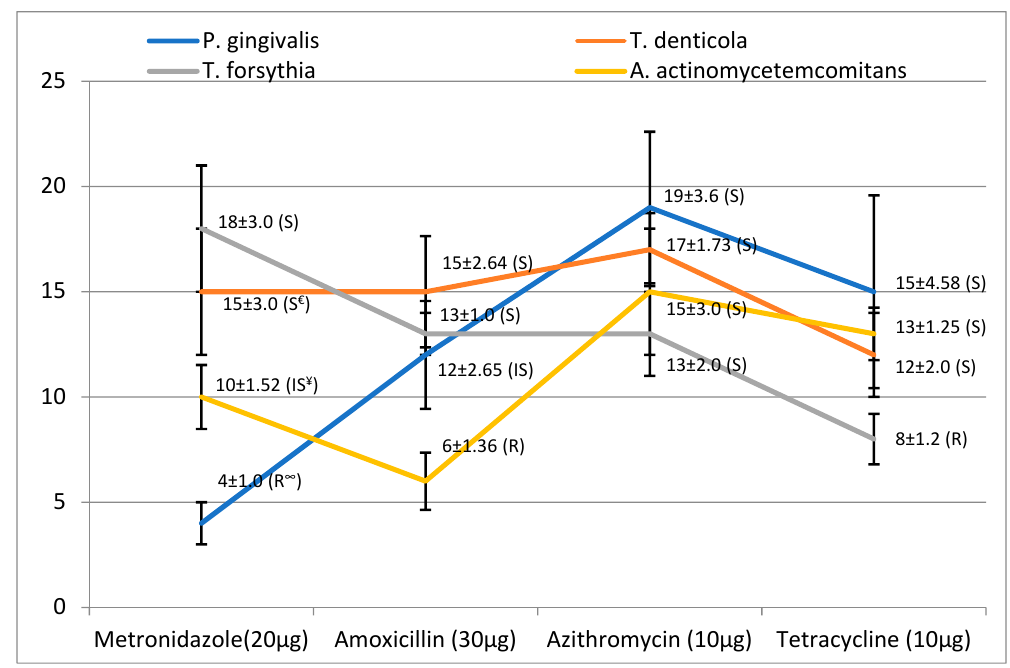
Figure 3. Antibacterial activity of antibiotics against periodontal pathobionts. ∞ = Resistant; € = Sensitive; ¥ = Intermediate sensitive.